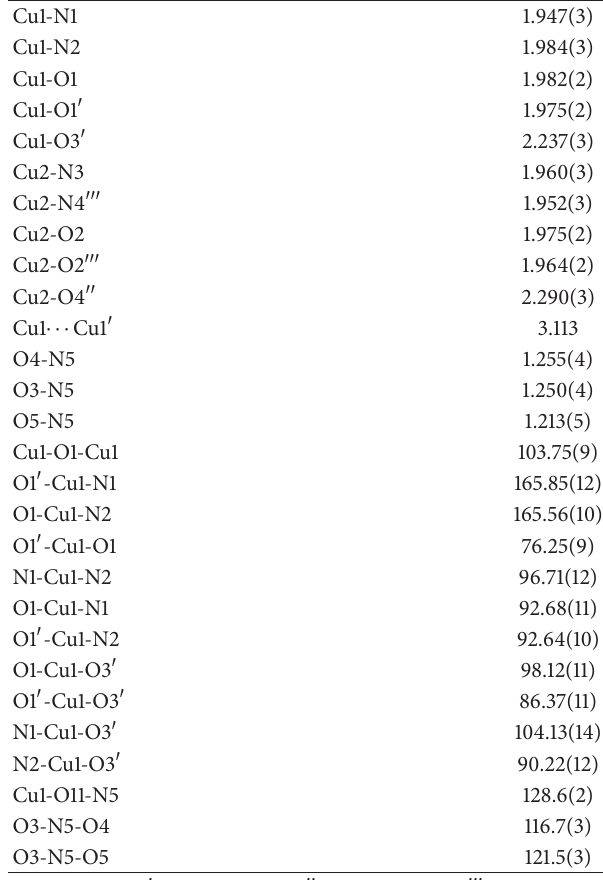
Table 2: Selected bond lengths/˚A and angles/ ∘ for [ { Cu 2 (tidf)( 𝜇 - NO 3 ) } ∞ ]ClO 4